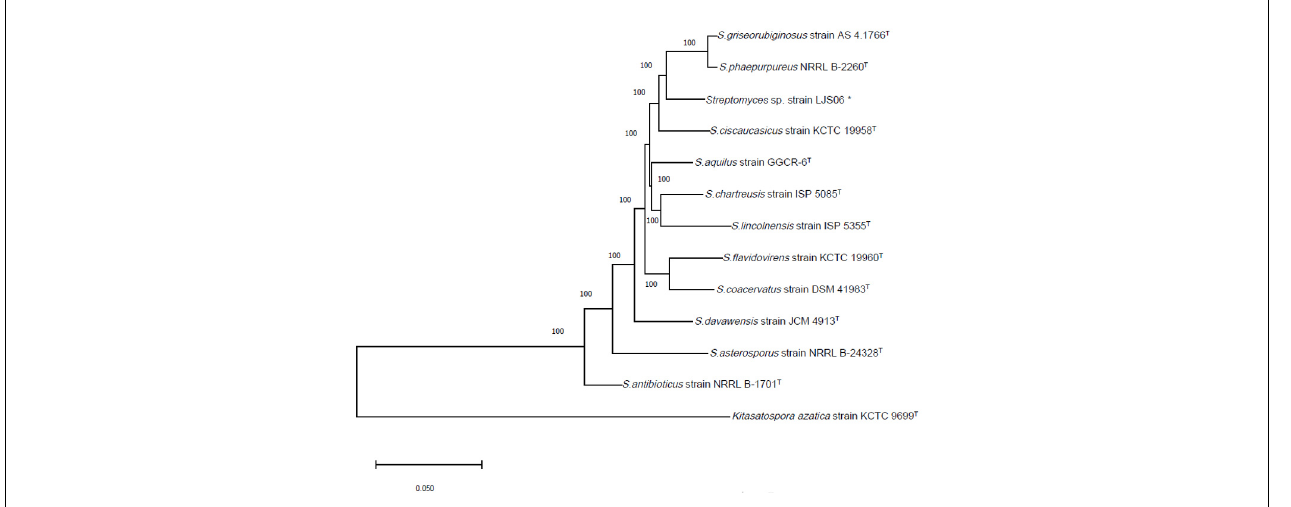
FIGURE 4 | Phylogenetic tree of Streptomyces species based on concatenated sequences of partial atpD , rpoB , and trpB genes. The tree was constructed using the Neighbor Joining method with the Tamura-Nei model and 1,000 bootstrap replicates in MEGA X. Kitasatospora azatica strain KCTC 9699 T was used as an outgroup. *Indicates the strain used in this study.